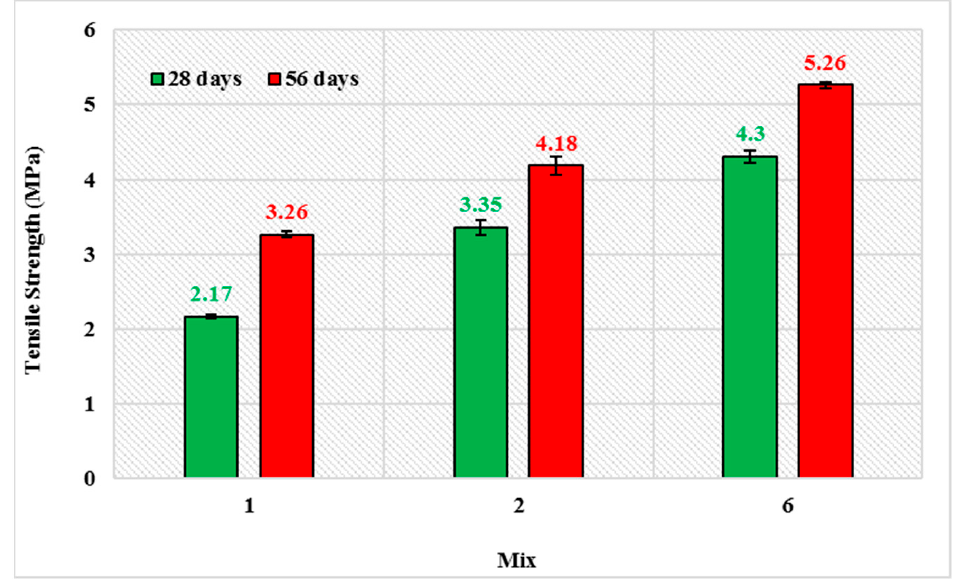
Figure 6. Effect of SF and MW on concrete splitting tensile strength.